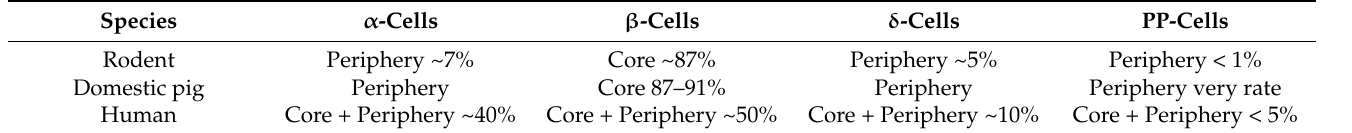
Table 1. Construction of pancreatic islets of selected